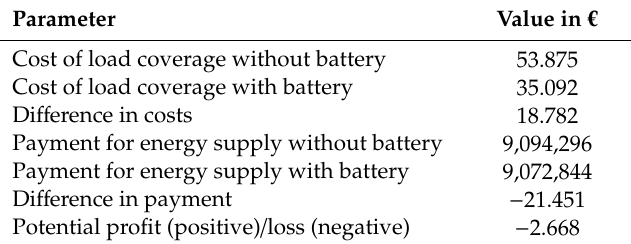
Table 4. Results for the adopted model.